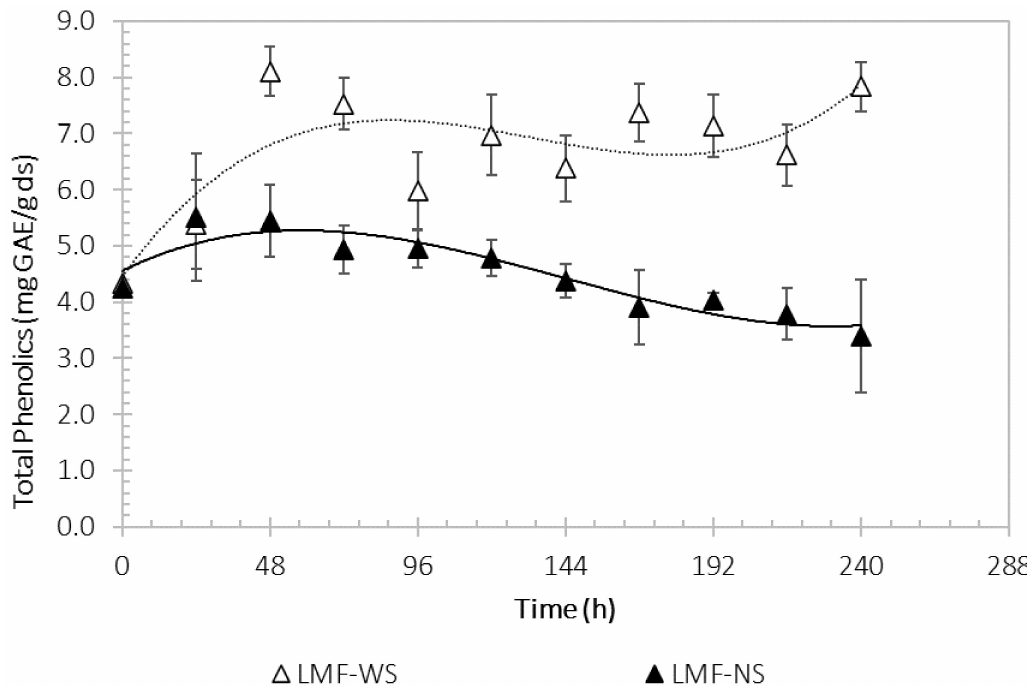
Figure 3. Process kinetics of total phenolic compounds by Aspergillus niger M4, using washed Sargassum (light color) and natural Sargassum (solid color) as substrate.